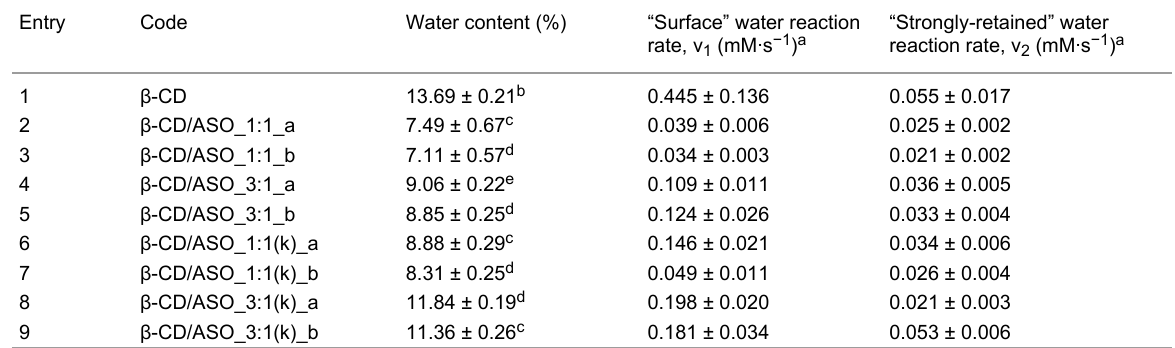
Table 2: Water content and mean water reaction rates, ν , in the main time ranges (10–30 s and 30–90 s) of β -CD/ASO complexes and commercial β -CD obtained by the KFT method.